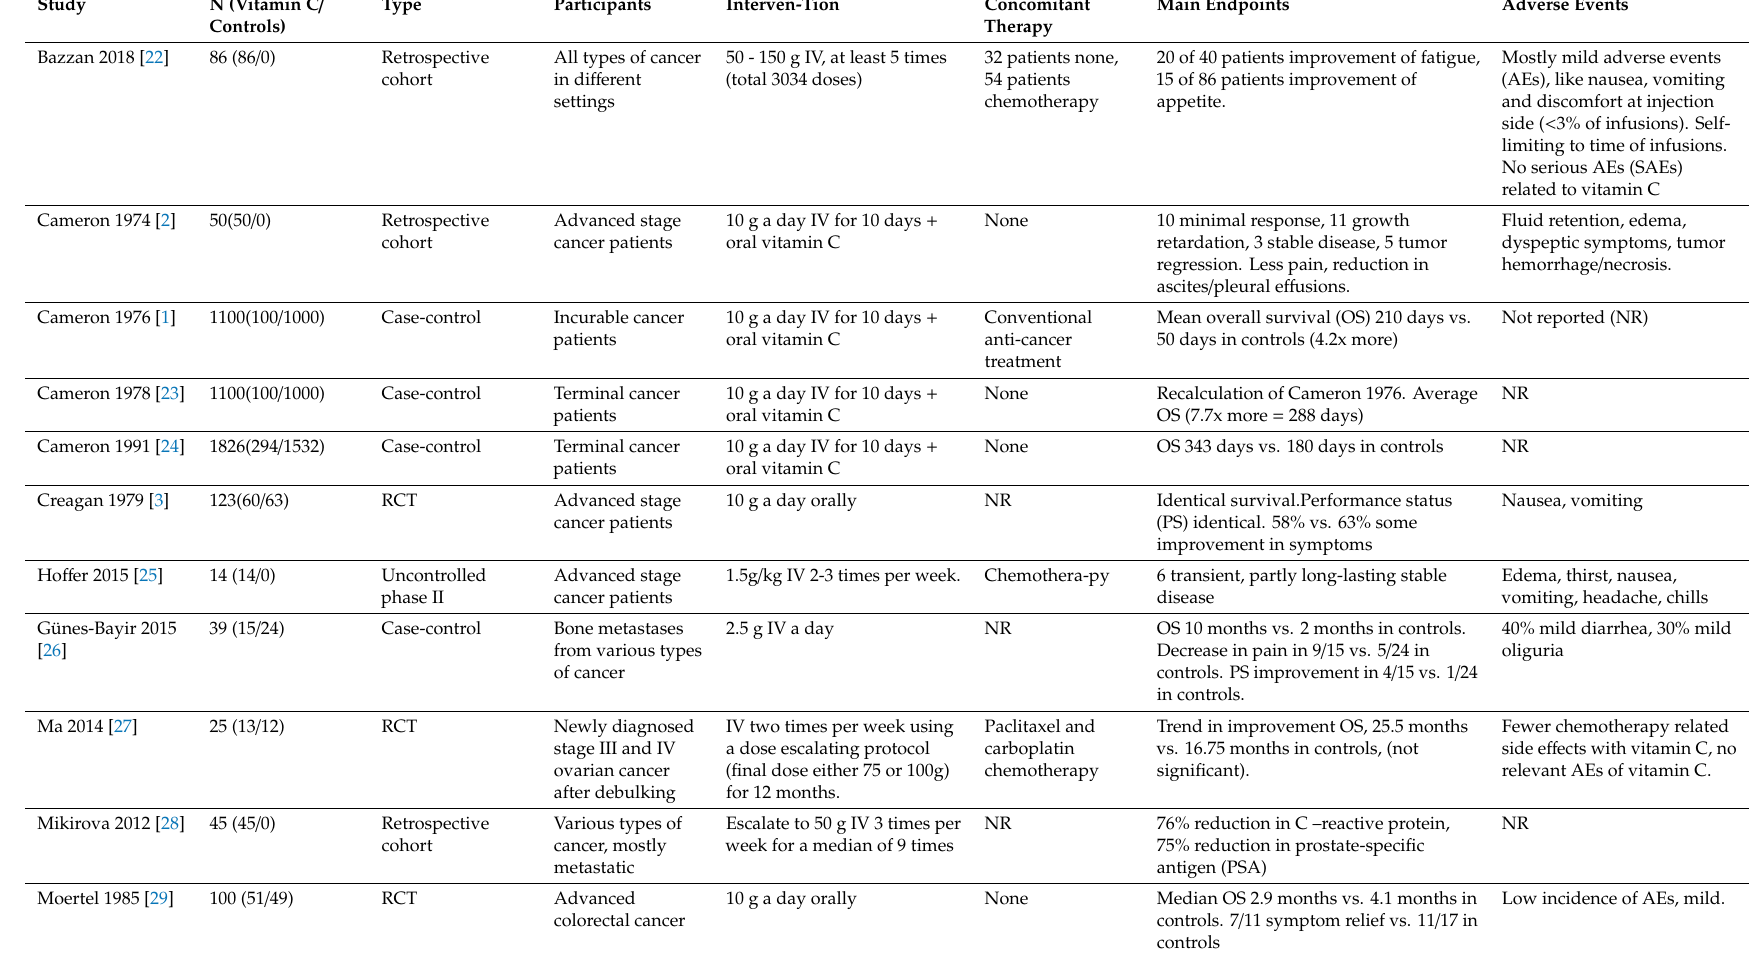
Table 1. Characteristics and outcome of the included studies in alphabetical